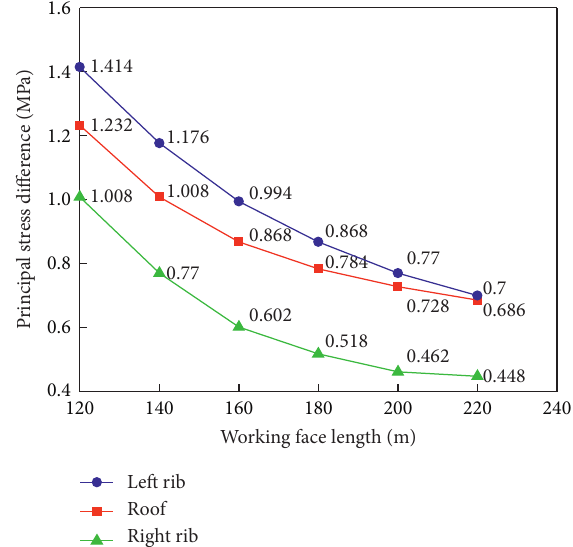
Figure 8: Principal stress differences at different coal internal friction angles.